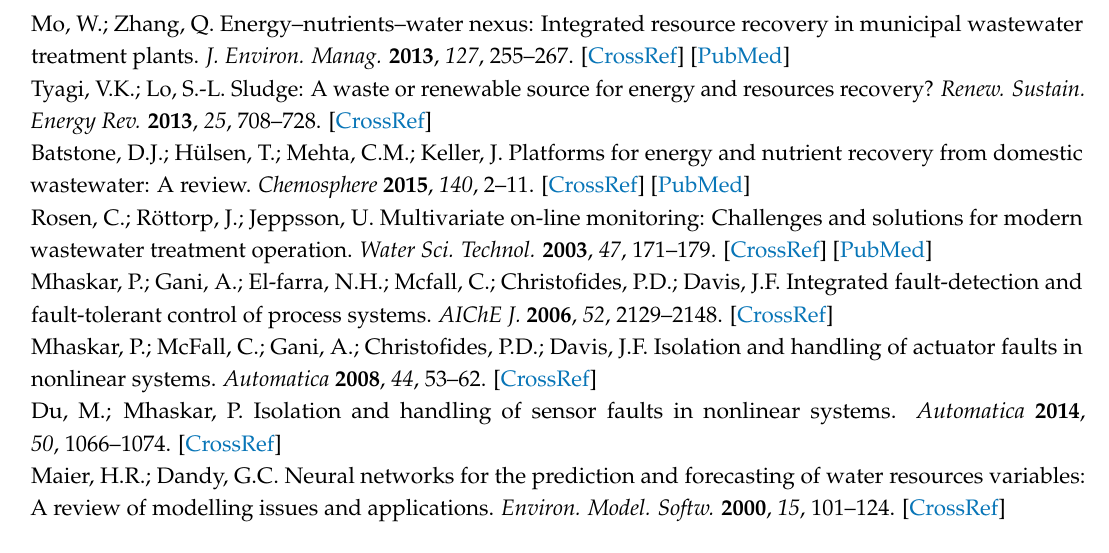
µ for faulty scenario 3. Figure 10. Residual of the estimated model parameter µ o for faulty scenario o